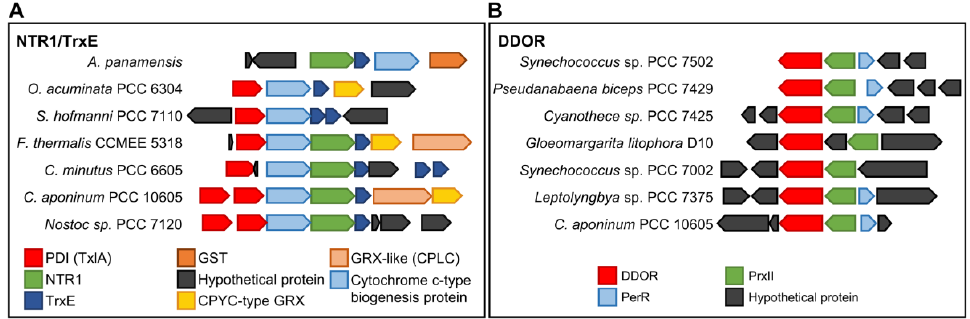
Figure 4. Gene neighborhood conservation of NTR/TrxE ( A ) and DDOR ( B ) from different cyanobacterial genomes. Note that proteins encoded by each gene are indicated.